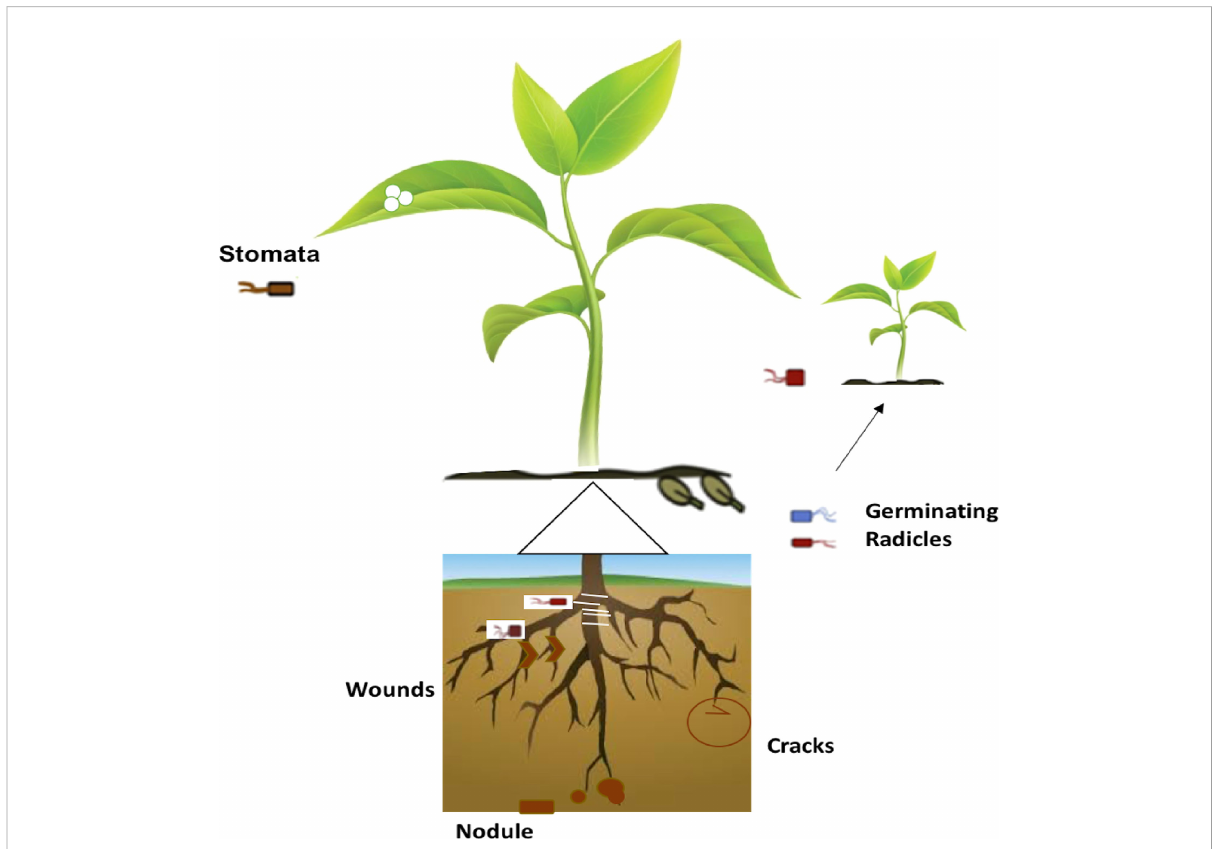
FIGURE 2 Overview of the endophytic bacterial mode of entry into different plant